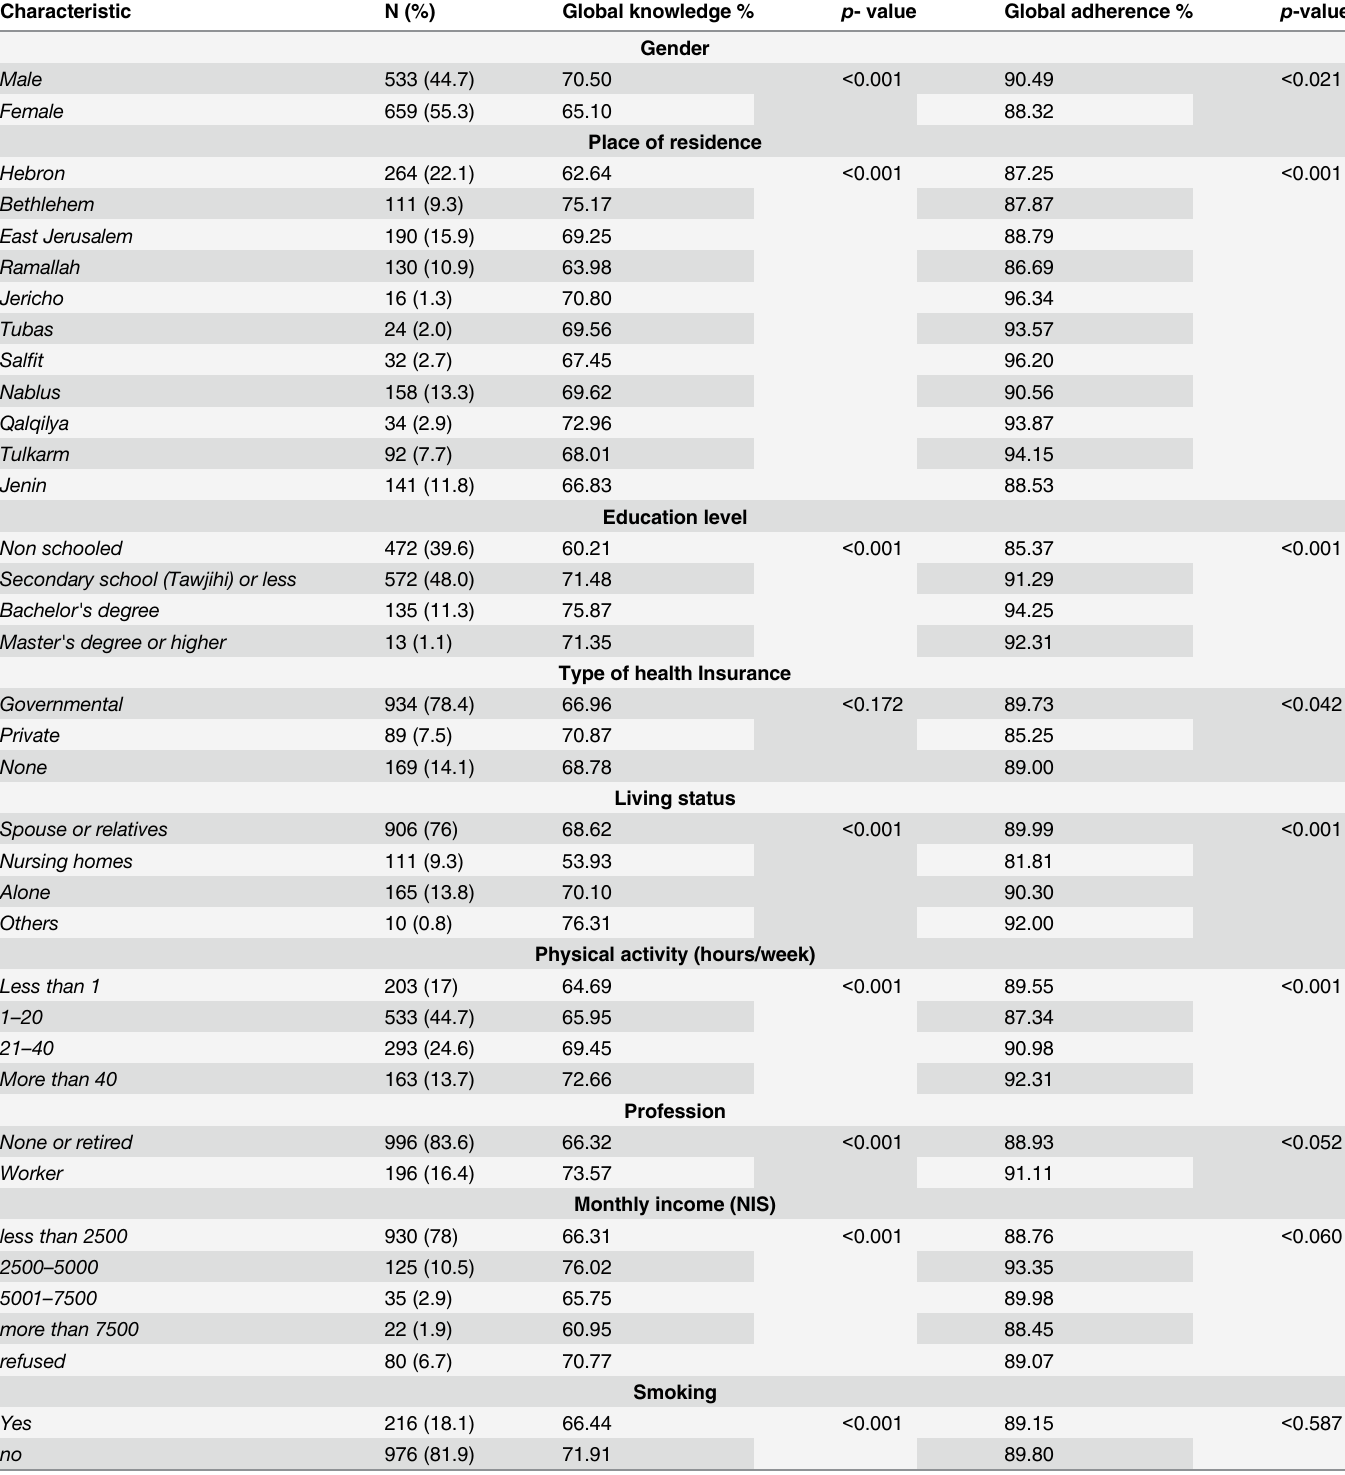
Table 1. Descriptive data calculated for 1192 Palestinian geriatrics living in the West Bank and